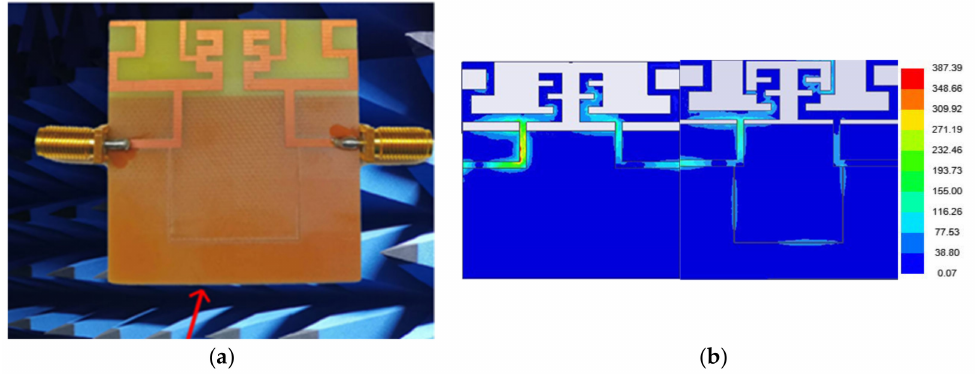
Figure 1. MIMO antenna with NLs: ( a ) fabricated MIMO antenna; and ( b ) comparison of current distributions without and with grounding NLs (Results from Liu et al.